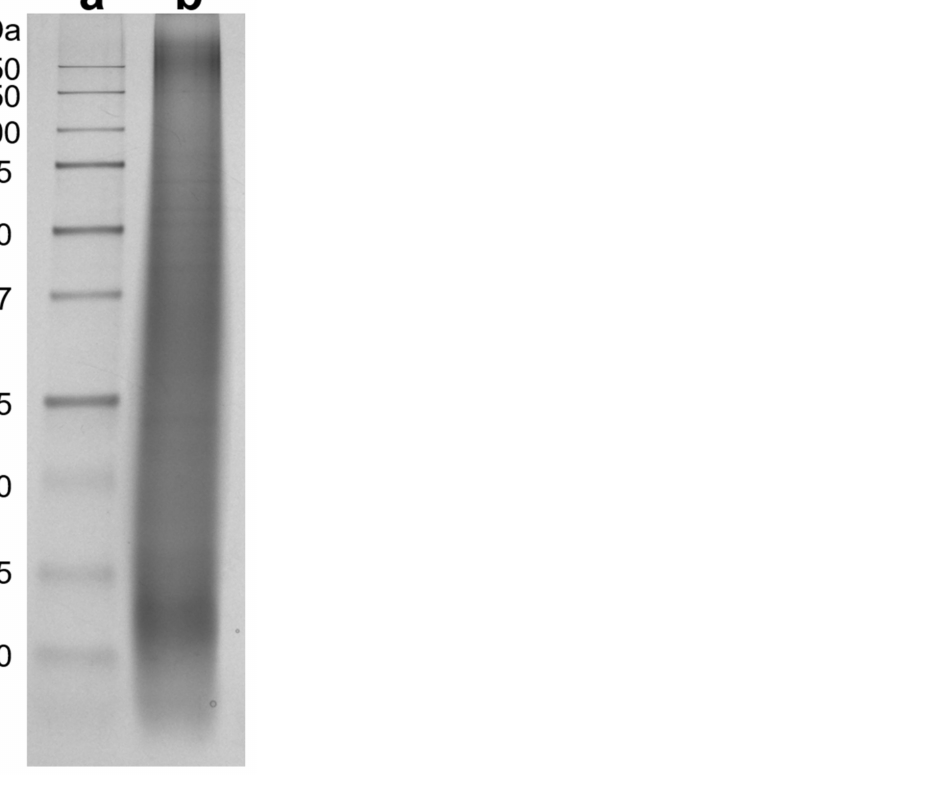
Figure 1. SDS-PAGE of ( a ) standard protein markers and ( b ) 0.1 wt.% specified risk materials